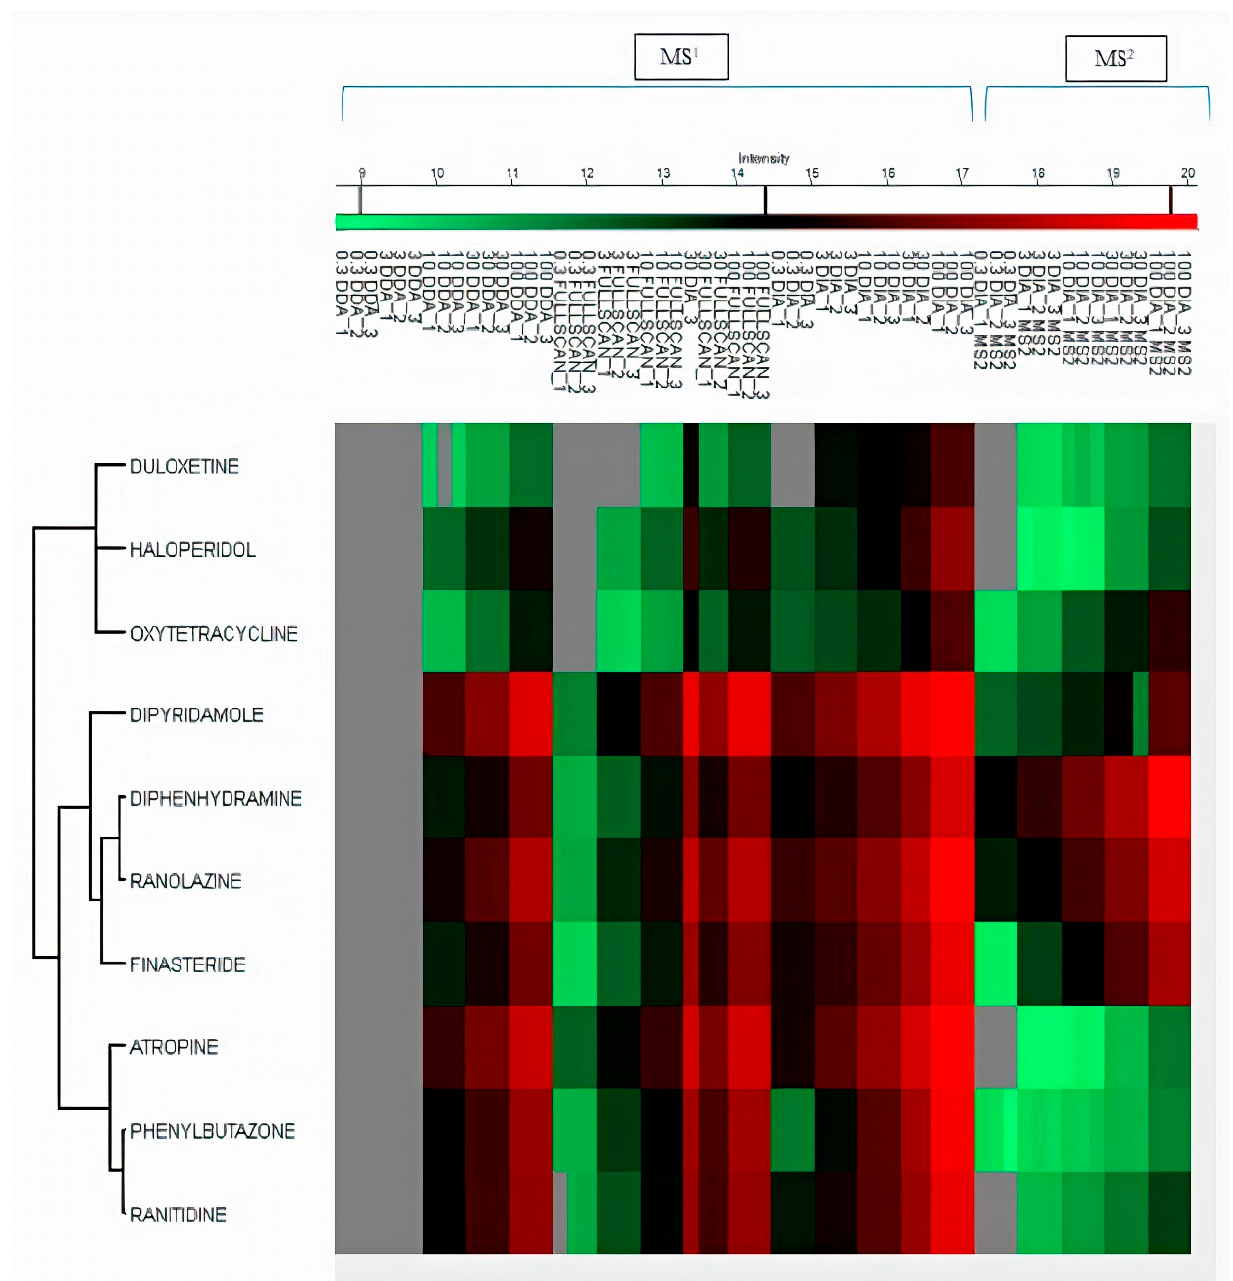
Figure 5. Clustering heatmap of MS1 data of 10 drugs compared between MS1 full scan, DDA, and DIA. DIA MS2 data of all drugs compared between DIA MS1 in all dilution points with replicates.